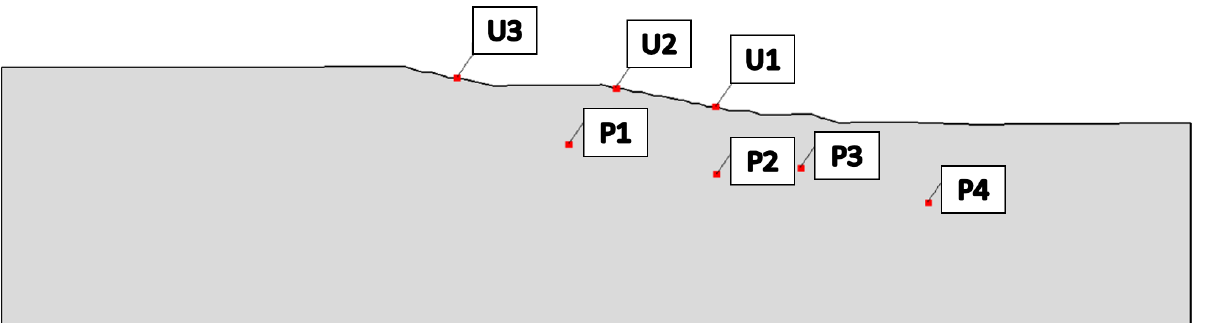
Figure 7: Sensor location in numerical model.